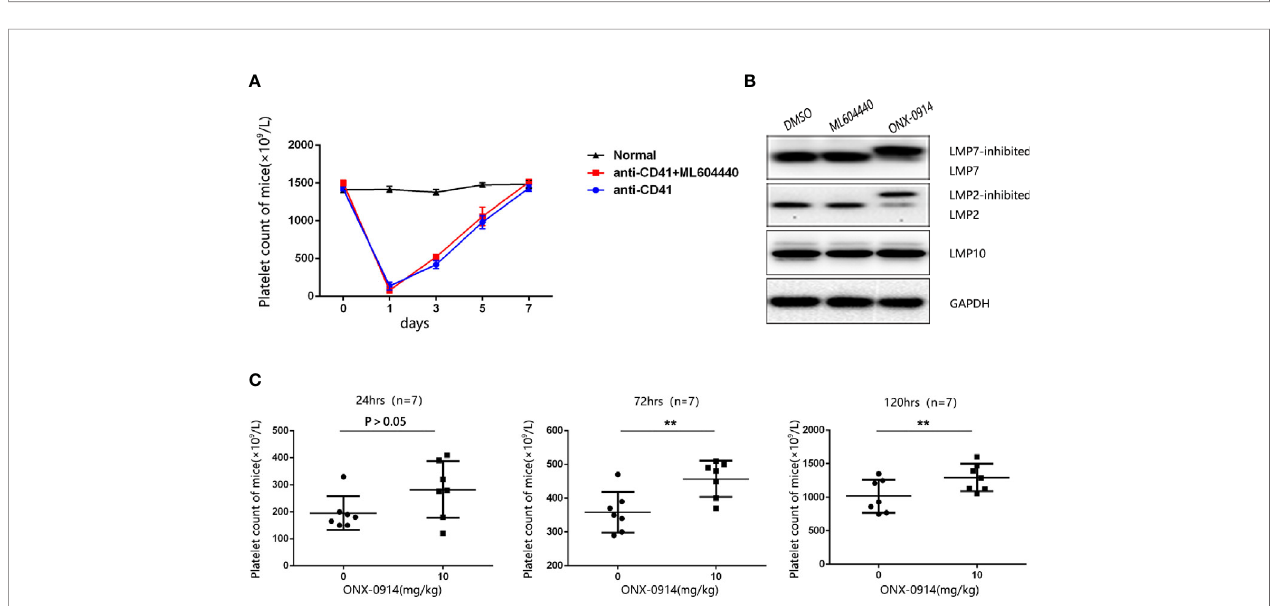
FIGURE 2 | ONX-0914 but not ML604440 reversed thrombocytopenia in ITP mice. (A) ML604440 (10 mg/kg) everyday did not signi fi cantly improve platelet counts in mice immunized by monoclonal rat anti-mouse CD41 platelet antibody. (B) Altered electrophoretic mobility of IP subunits by covalent modi fi cation with ONX 0914. Shown are representative Western blots out of three independent experiments with similar outcome. (C) ONX-0914 (10 mg/kg) everyday improved platelet counts in mice at 24 hours, 72 hours and 120 hours after immunization. **P <